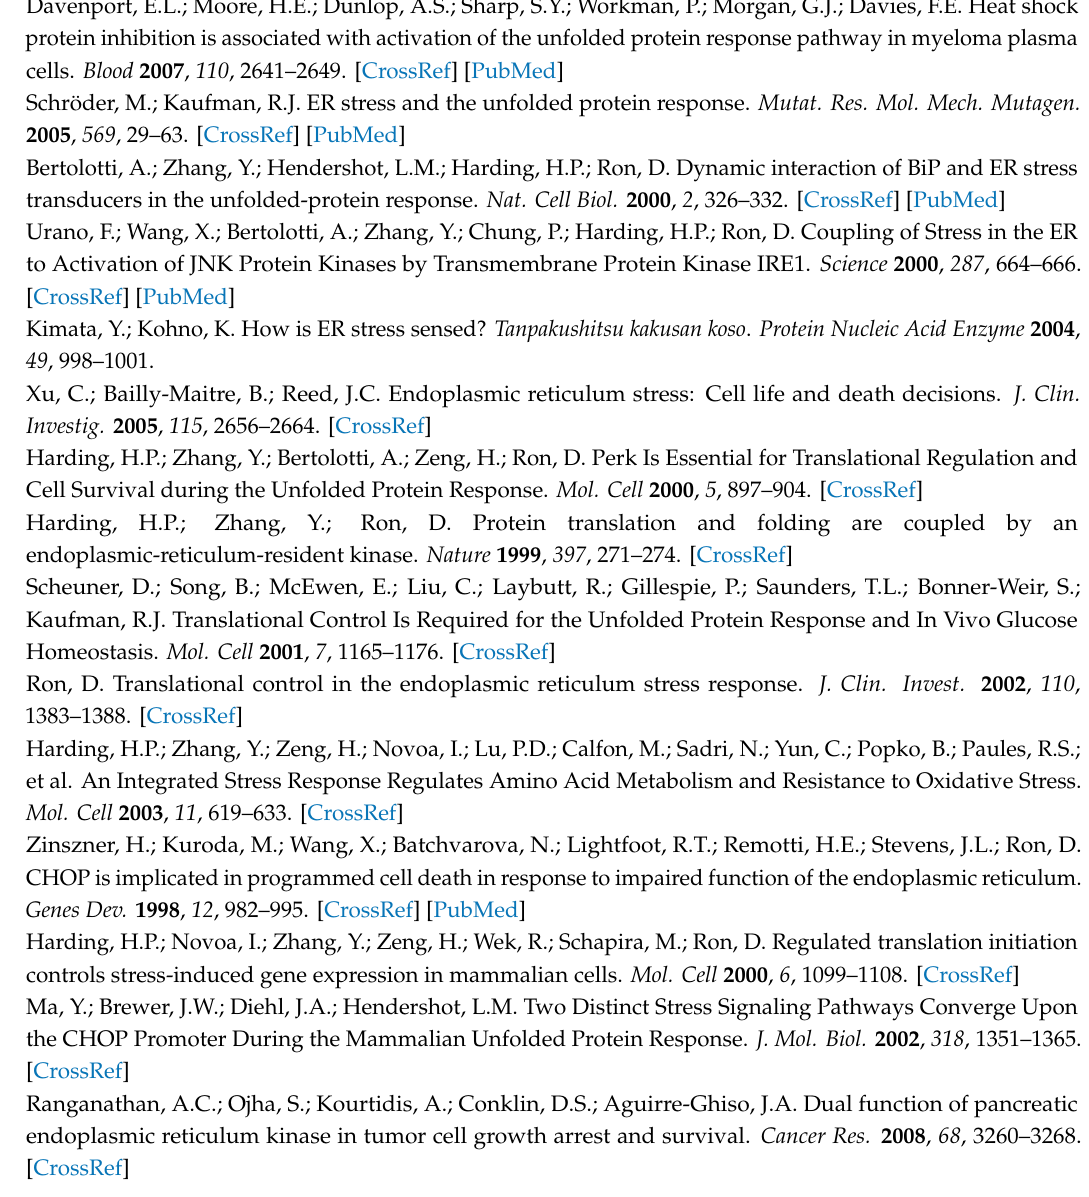
Figure S1: Correlation of PERK expression levels with sensitivity to PERK inhibition in all cell lines, Figure S2: Apoptosis related proteome profiler in H929 and L363 cell lines, Figure S3: (A1) Relative protein expression in L363 cells of the 35 indicated apoptosis-related proteins in GSK2606414 (10 µ M) treated vs. untreated (Con) cells, (A2) Relative protein expression in L363 cells of the 35 indicated apoptosis-related proteins in BTZ (4 nM) vs. BTZ (4 nM) / GSK2606414 (10 µ M) treated cells, Figure S4: (A1,A2): Uncropped western blot images of Figure 1A2. (B1,B2): Uncropped western blot images of Figure 3B2. (C): Uncropped western blot images of Figure 4A2. (D): Uncropped western blot images of Figure 4B1. (E): Uncropped western blot images of Figure